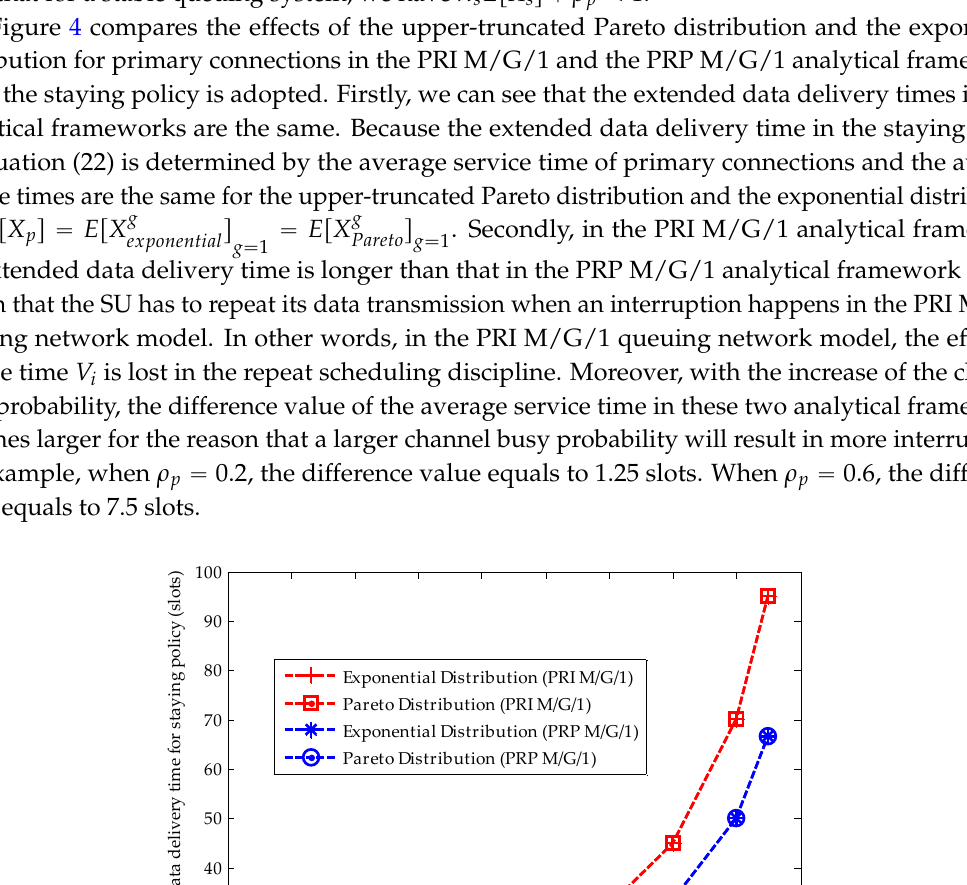
Figure 5. Effects of the upper-truncated Pareto distribution and the exponential distribution for primary connections when the changing policy is adopted in the preemptive repeat identical (PRI) M/G/1 and the preemptive resume priority (PRP) M/G/1 queuing network models, where   0.01 s (arrivals/slot),